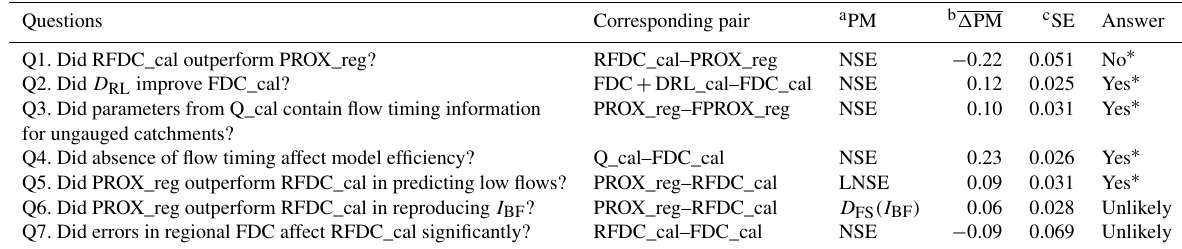
Table 3. Results of the paired t tests for potential questions on rainfall–runoff modelling in ungauged catchments. Questions Corresponding